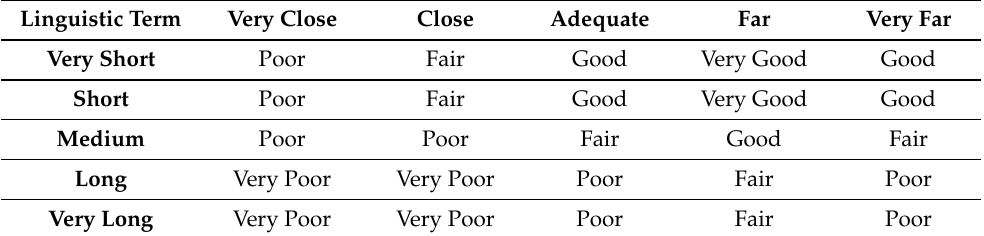
Table 3. Summary of rules used for Case Study II.